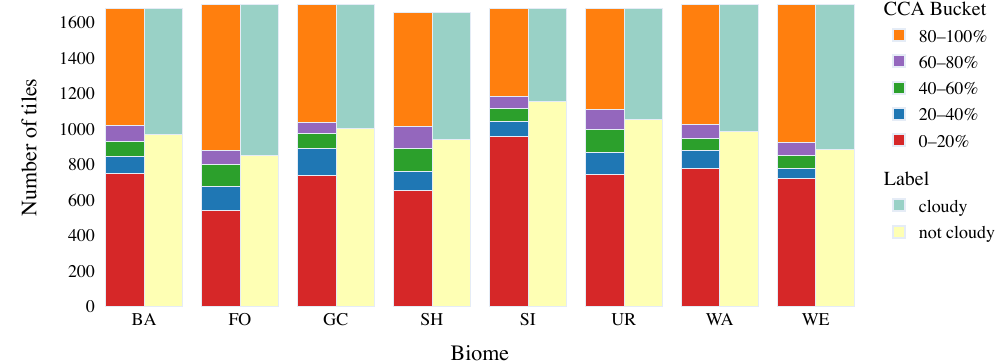
Figure 5. Distribution of the tiles and its CCA values per biome for the full L8 biome dataset. Tiles with CCA ≥ 70% are categorized as cloudy and the rest are categorized as not cloudy